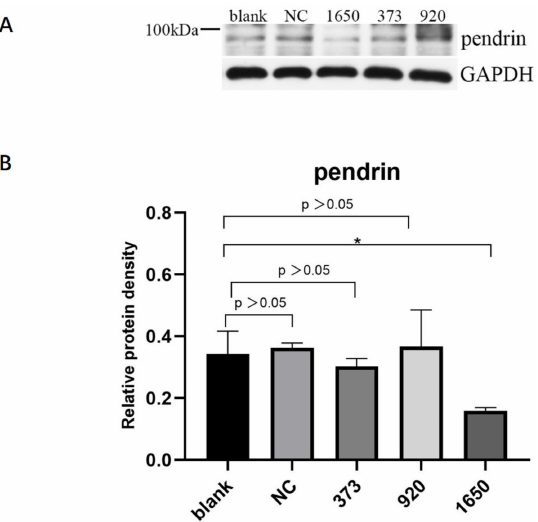
Figure 5. After transfection of HNECs with siRNA pendrin (NC, pendrin-373, pendrin-920, pendrin- 1650, and FAM NC), the protein expression of pendrin was downregulated, especially siRNA pendrin- 1650. ( A ) is the protein of pendrin after transfection siRNA pendrin, ( B ) is the density of ( A ) pendrin. * represents p < 0.05.